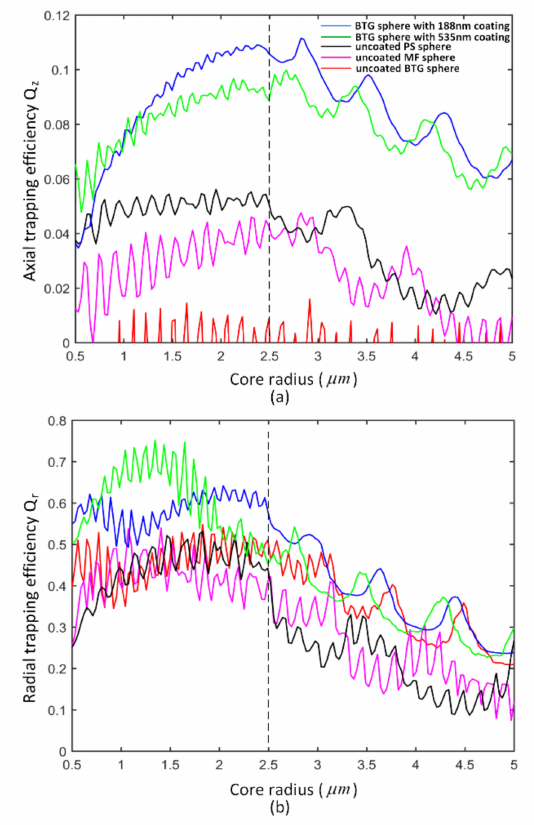
Figure 7. Axial ( a ) and radial ( b ) trapping e ffi ciency of di ff erent microspheres, including the uncoated PS / melamine formaldehyde (MF) / BTG spheres and two coated BTG